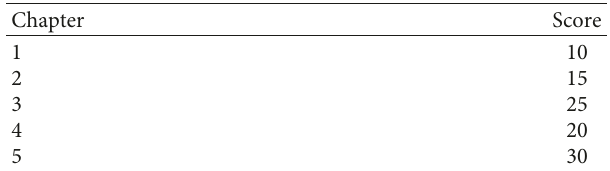
Table 2: Score of each